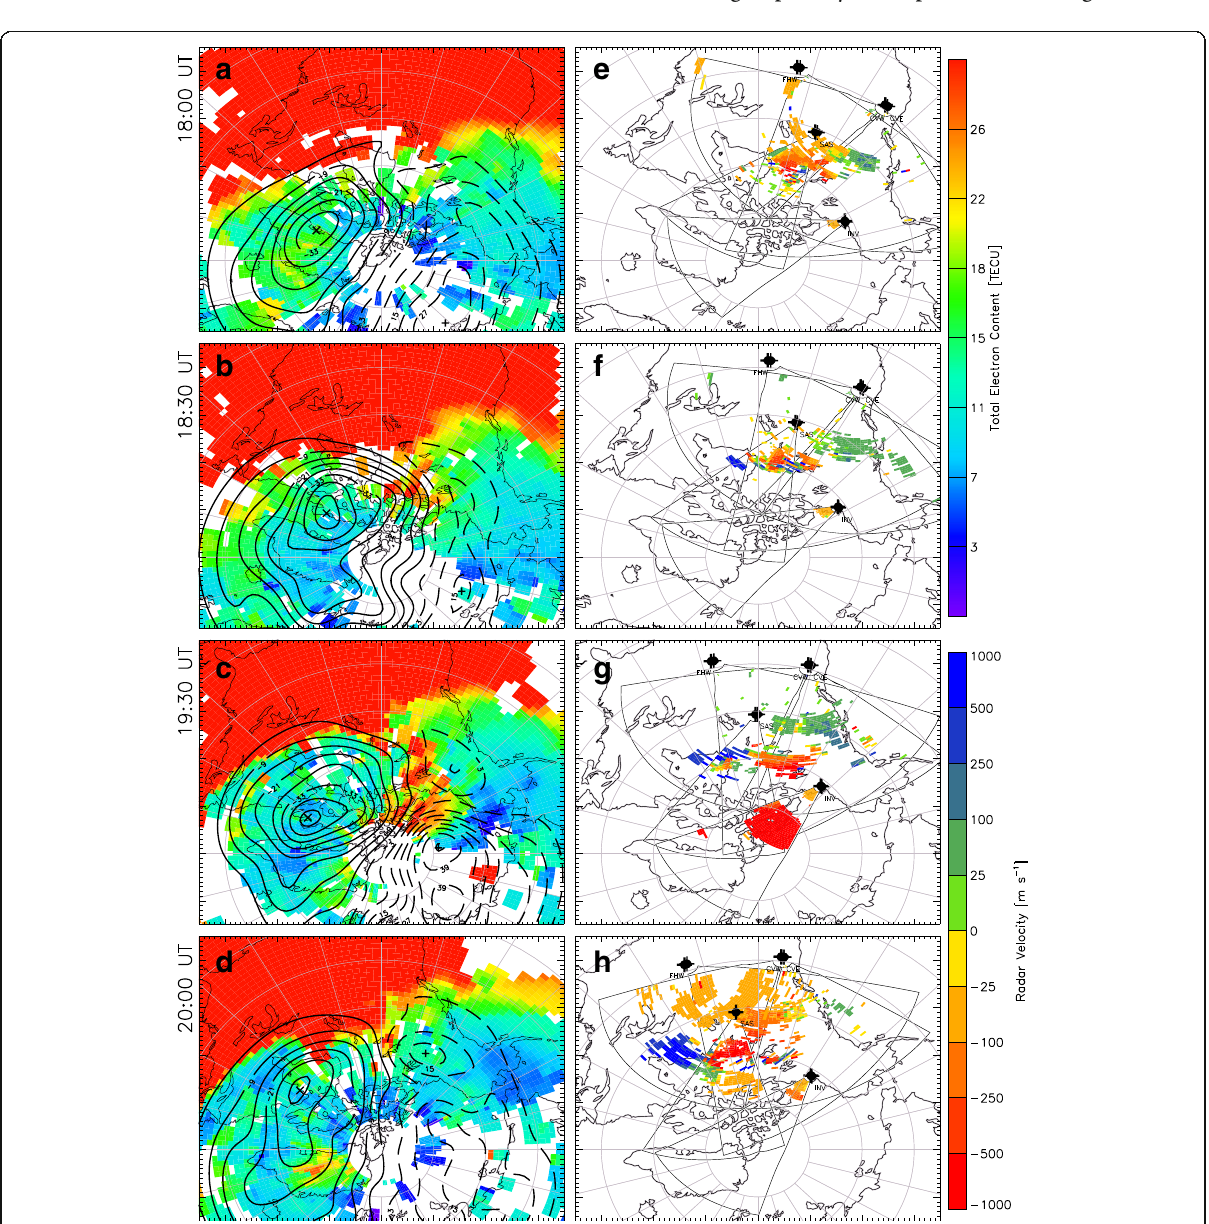
Fig. 8 a – d GPS TEC maps depicting evolution of the polar tongue of ionization (TOI) with SuperDARN convection patterns overlaid. e – h SuperDARN LOS velocity measurements from radars located at mid-latitudes on the dayside and extending into the polar cap. Reproduced from Fig. 7 of Thomas et al.